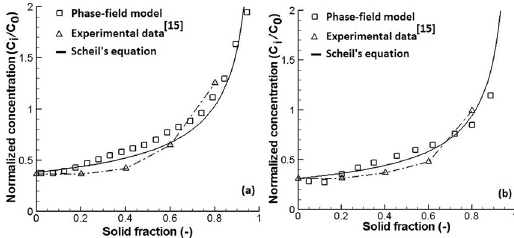
Figure 6: Comparison between experimental microsegregation profiles and predictions furnished by Scheil's equation and the phase-field model with K : (a) Al–2.64×10 –2 mol%Cu and (b) ef Al–4.5×10 –2 mol%Cu